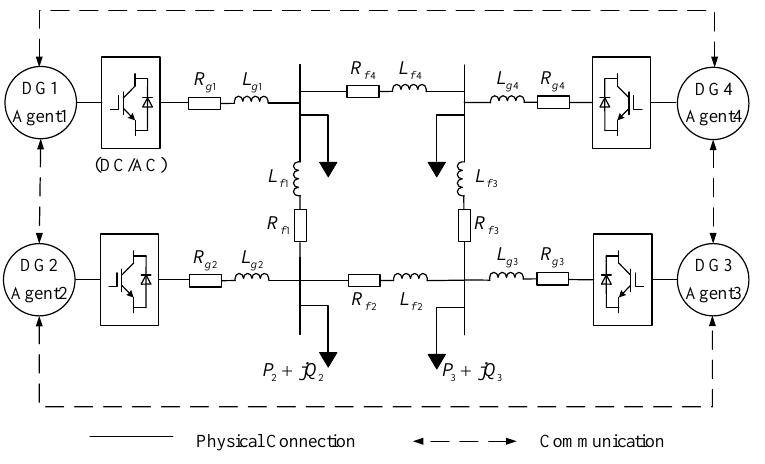
Figure 4. Islanded microgrid test system. Table 1. Parameters of the islanded microgrid test system.